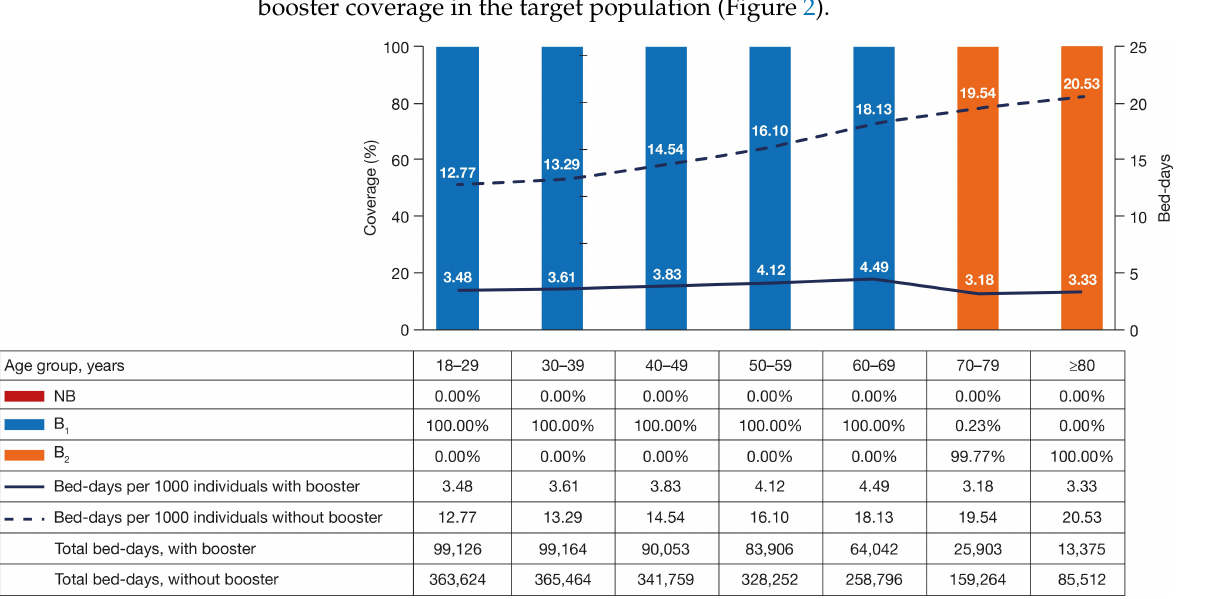
Figure 2. Best BAS in Brazil (base case country). BAS, booster allocation